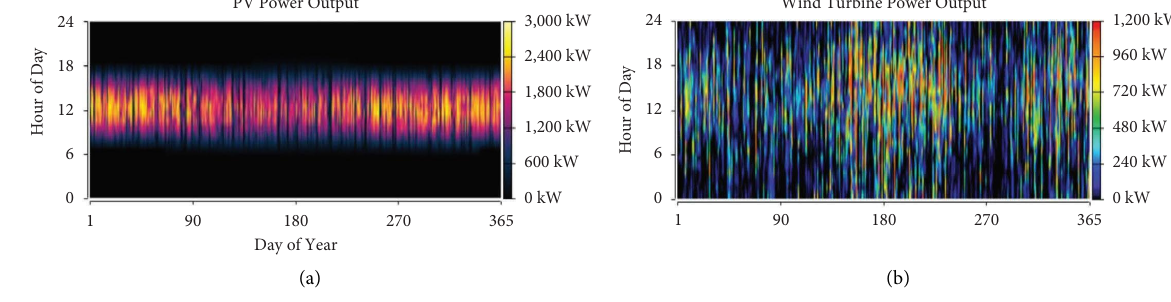
Figure 18: (a) PV output and (b) WT